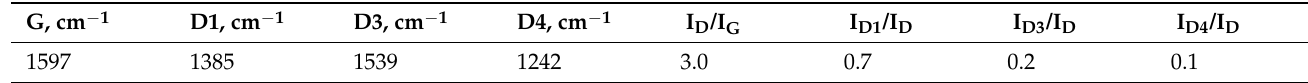
Table 1. Results of the Raman spectra